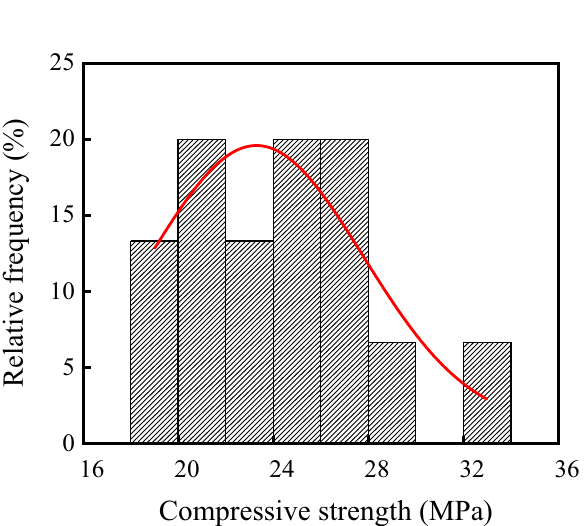
Table 3. Compressive strength of concrete in the ammonium sulfate workshop.